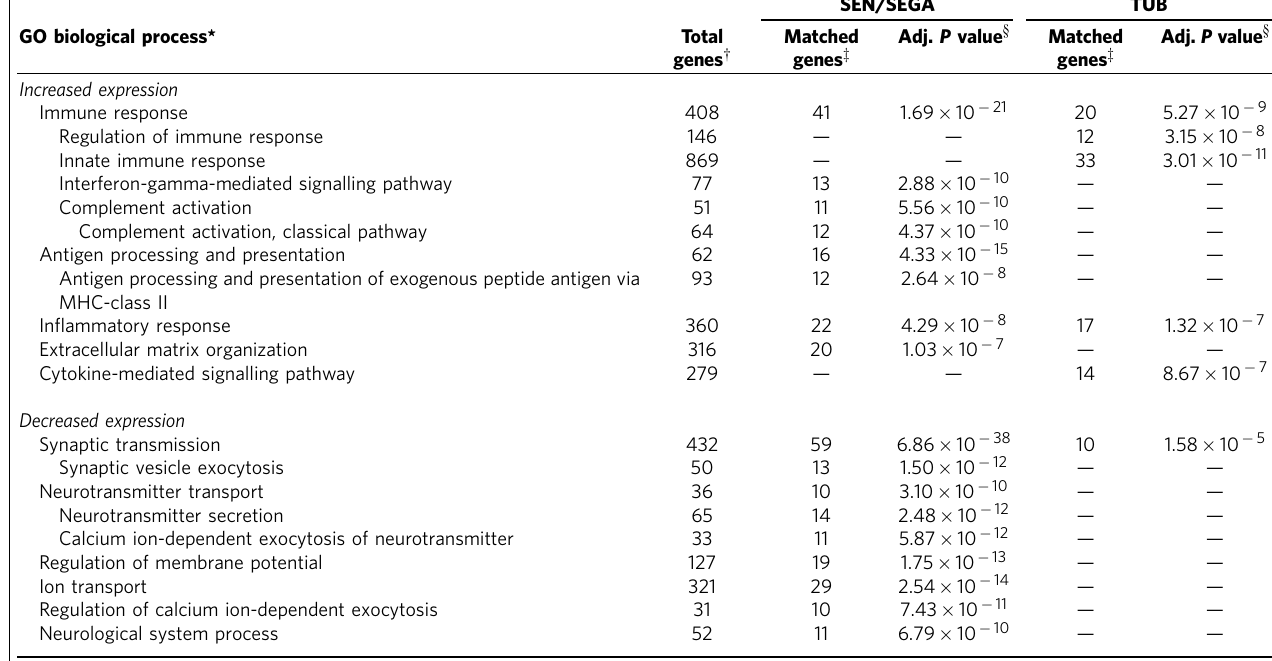
Table 2 | Network analysis of top DEGs in TSC-associated brain